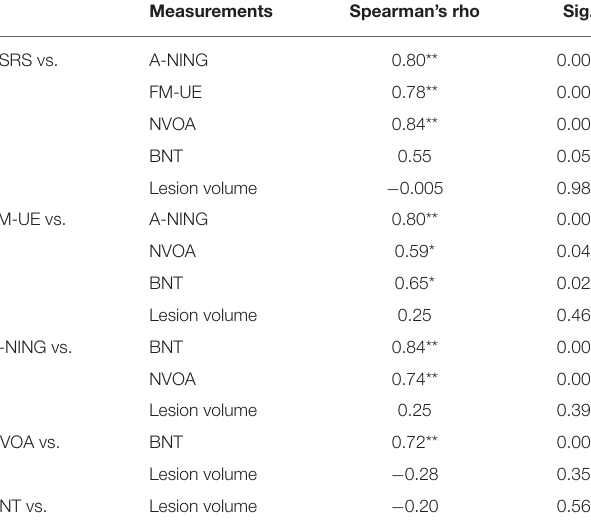
TABLE 6 | Relation between recovery